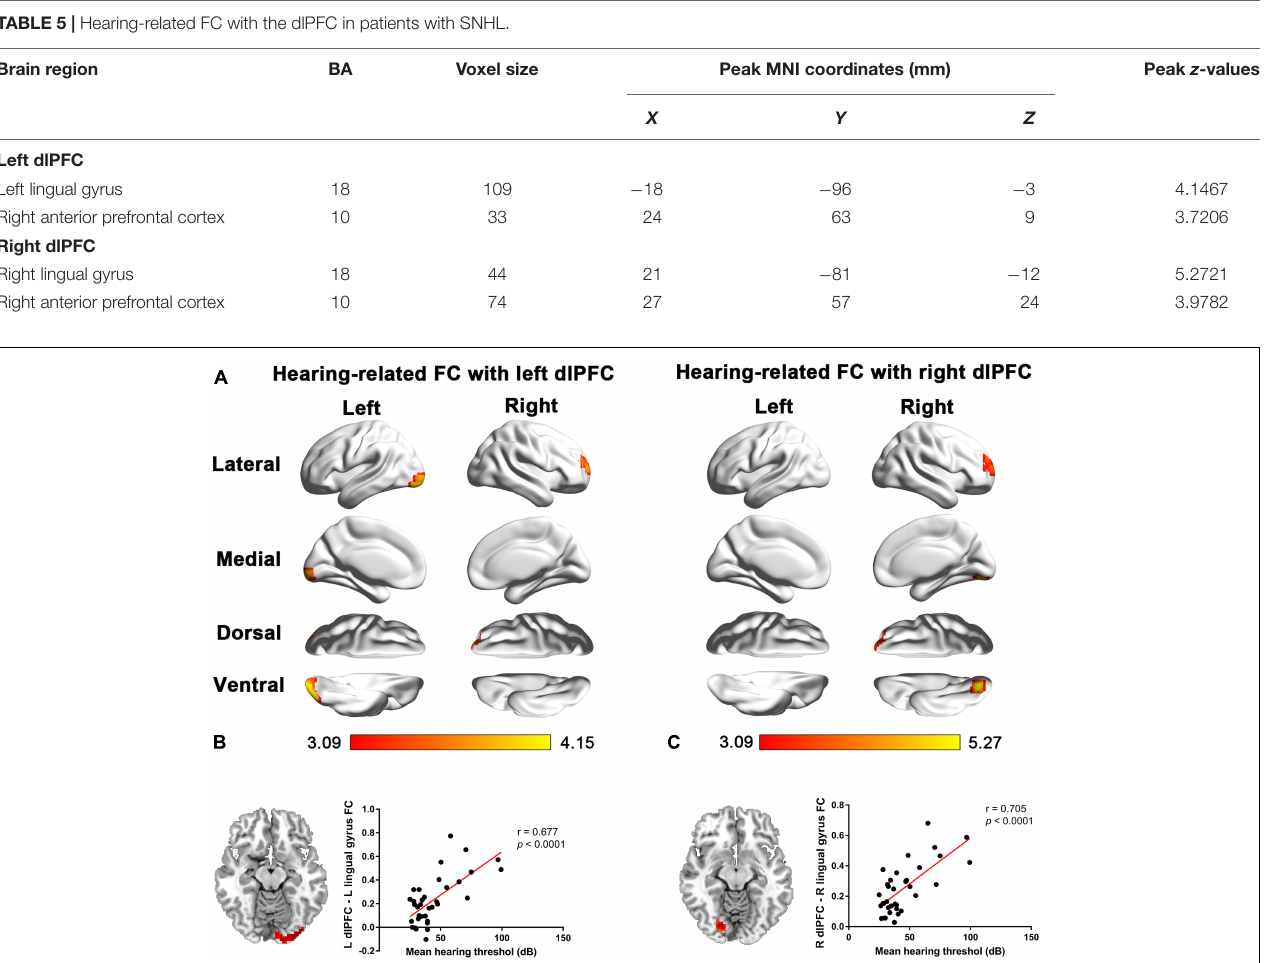
FIGURE 5 | (A) Voxel-wise hearing-related FC patterns with the left and right dlPFC in patients with SNHL, independent of age, sex, and education. Significant positive correlations are presented in the red-yellow heat scales. The color bar below shows the z -scores. The scatterplots show the correlations in the patients with SNHL between the binaural mean hearing thresholds with the mean left dlPFC-seeded FC in the left lingual gyrus (B) and the mean right dlPFC-seeded FC in the right lingual gyrus (C) , which were shown to be significant by the voxel-wise correlation analysis, after controlling for the effects of age, sex, and